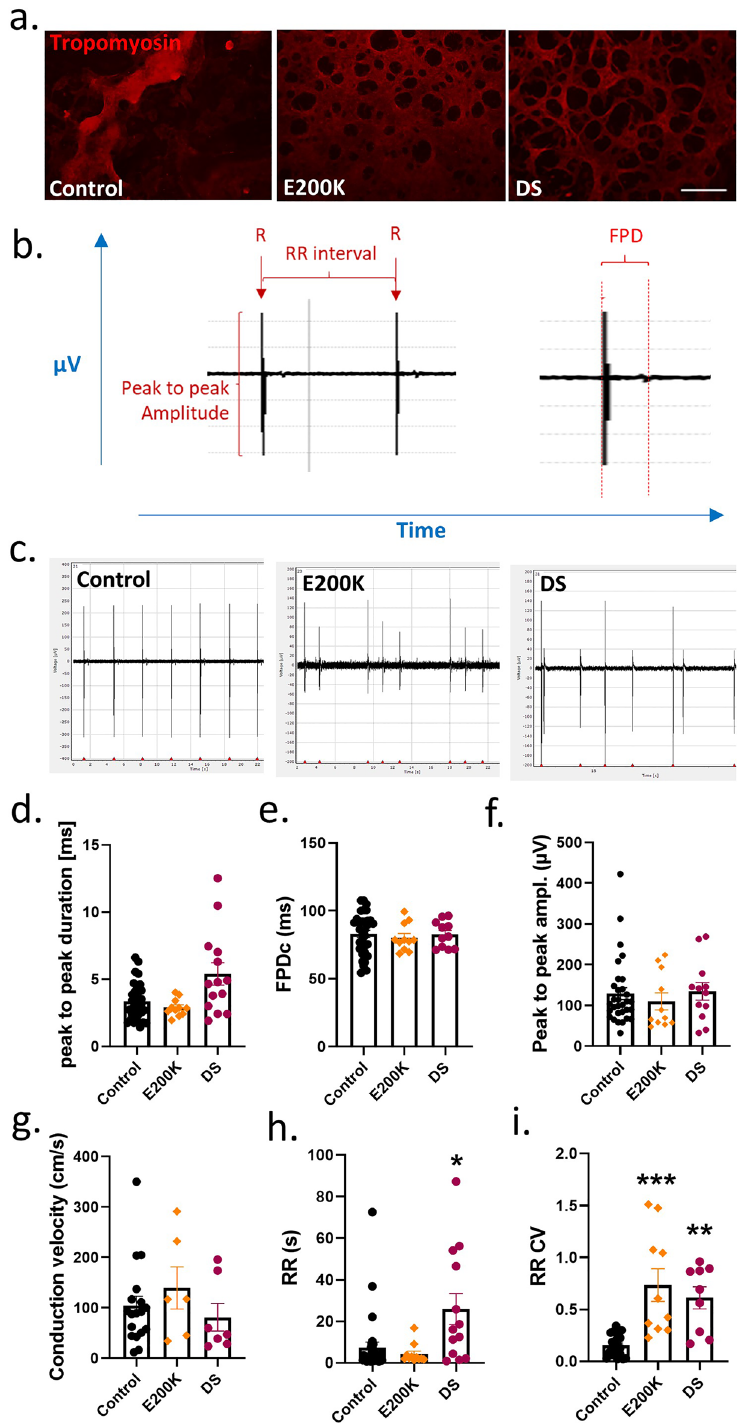
Figure 1. E200K and DS cardiomyocytes have altered electrophysiology. ( a ) Tropomyosin staining of the differentiated cardiomyocytes, scale bar = 100 µm. ( b ) Schematic showing measured parameters. ( c ) Representative traces for the control, E200K and DS cardiomyocytes (y axes are not equivalent but scaled to show detail). Graphs showing ( d ) peak to peak amplitude, ( e ) peak to peak duration, ( f ) field potential duration (corrected to RR interval; FPDc), ( g ) conduction velocity, ( h ) RR interval and ( i ) RR coefficient of variance (variability of the RR interval). Graphs show data points of each independent biological repeat ‘ n ’ with mean and SEM, *p < 0.05, **p < 0.01, and ***p <